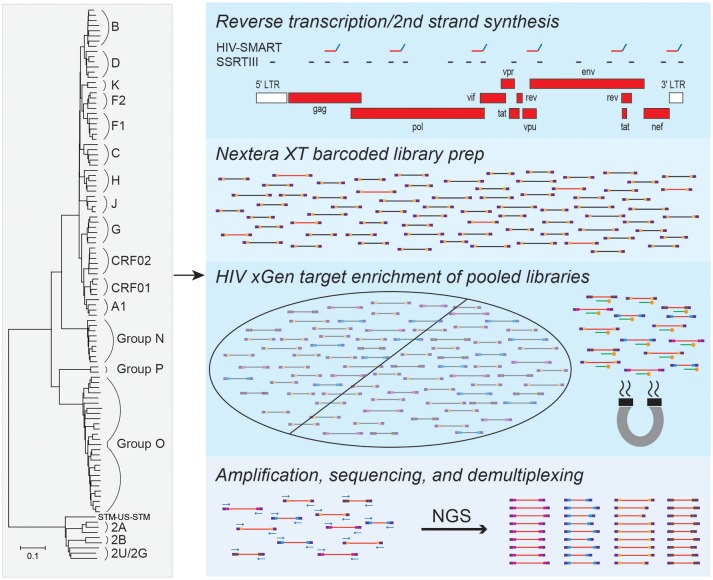
HIV-xGen strategy. 651 probes were selected to tile all HIV-1 and HIV-2 strains present in the phylogenetic tree at 1X coverage. Reverse transcription and second strand synthesis were performed by random priming with Superscript/Sequenase or by the HIV-SMART method. Nextera XT was used to convert cDNA to barcoded Illumina libraries consisting of both HIV (red inserts) and background (black) reads. Pooled libraries were hybridized to xGen probes (green) with 5′-biotin tags (gold) for a single capture and selected by magnetic bead separation. Multiplexed libraries were amplified by universal KAPA primers, sequenced on a MiSeq, and reads were parsed by barcode.